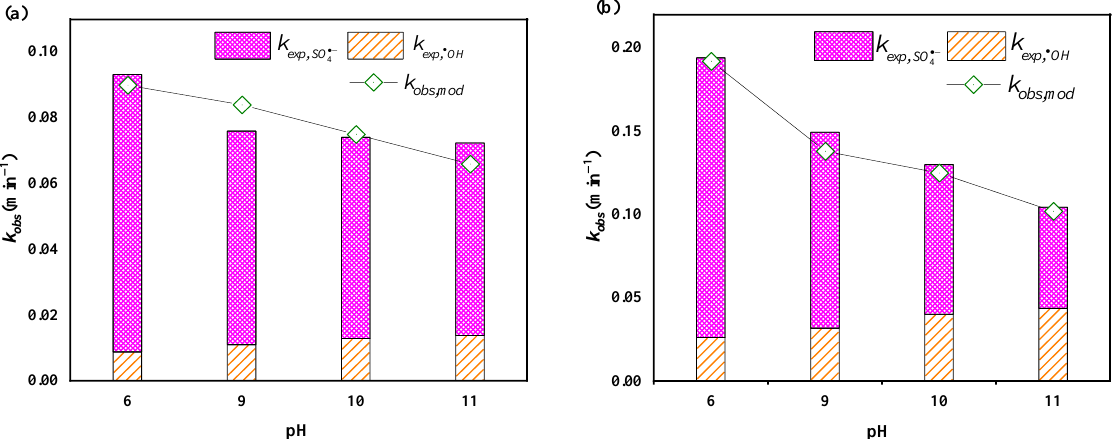
Figure 4. Effects of solution pHs on the radical contributions and k obs of ACY ( a ) and ATL ( b ) in UV/PDS process. Conditions: [ACY] 0 = 0.022 mM, [ATL] 0 = 0.019 mM, [PDS] 0 = 0.6 mM.